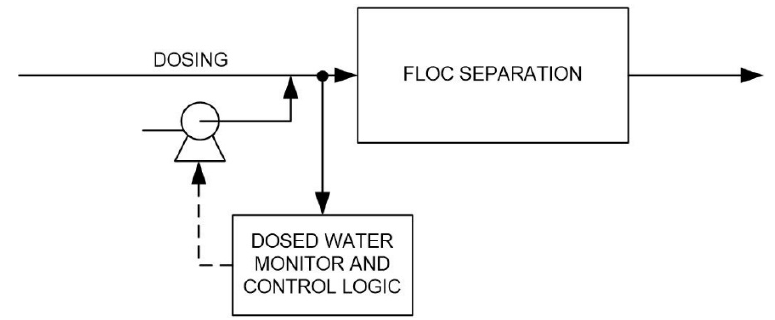
Figure 2. Sketch of a feed-backward control scheme based on dosed water